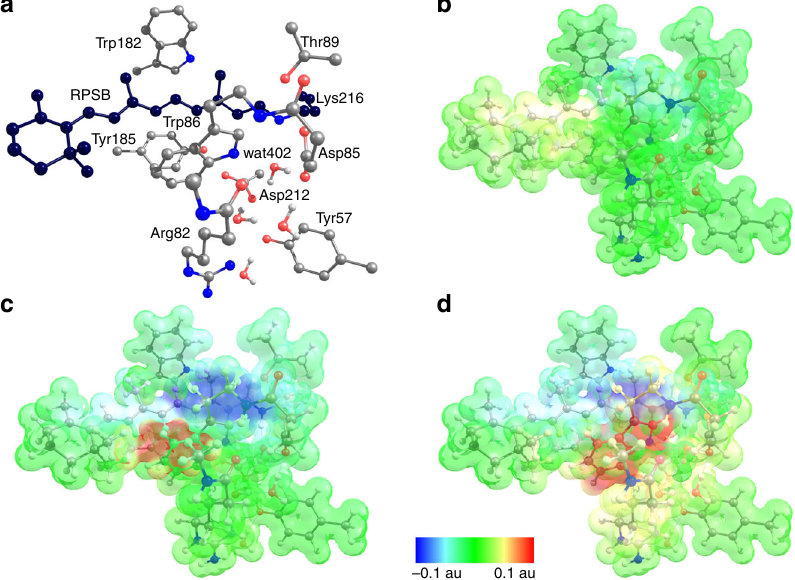
Fig. 3 Electrostatic potential changes illustrate the charge-transfer (CT) character. The transitions S 0 – S 1 , S 0 – CT(Y185) and S 0 – CT(W86) are characterized. a Bacteriorhodopsin active-site cluster model (consisting of the 208 atoms in total). The carbon atoms of the retinal protonated Schiff base (RPSB)-Lys216 fragment are shown in black. Hydrogen atoms, except for the water molecules, are not shown. b The S 0 – S 1 transition corresponds to the excited retinal; c The S 0 – CT(Y185) and S 0 – CT(W86) ( d ) transitions correspond to CT involving Tyr185 and Trp86 as electron donors to RPSB. In the S 0 state, the protonated Schiff base is positively charged. All electronic transitions decrease this positive charge as apparent from the light blue patch of the electrostatic potential surface in b and dark blue patches in c , d . The positive charge moves to the ionone ring of retinal as shown by the yellow patch in b or to the electron donor (Trp86, Tyr185) as shown by a red patch in c , d . The charge separation in the active site is much larger for the S 0 – CT transitions than for the